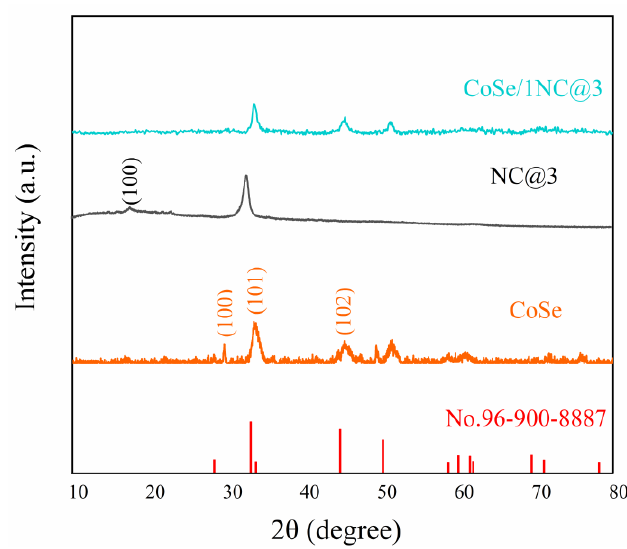
Figure 4. XRD pattern of CS/1NC@3, CoSe, NC@3.